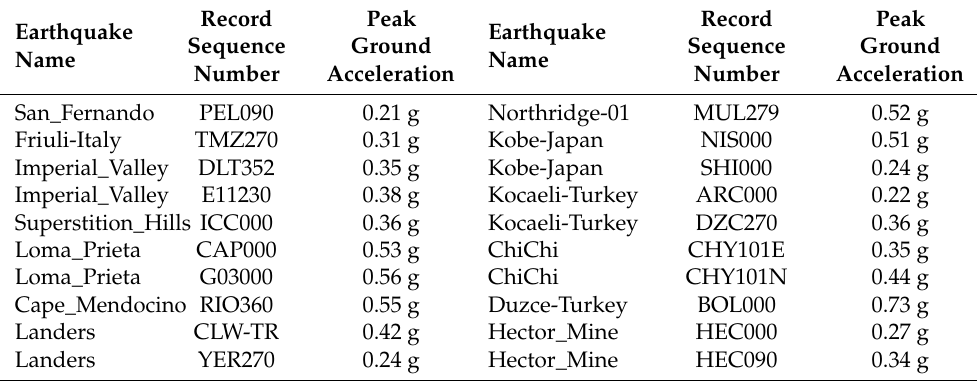
Table 3. The selected ground motion records.